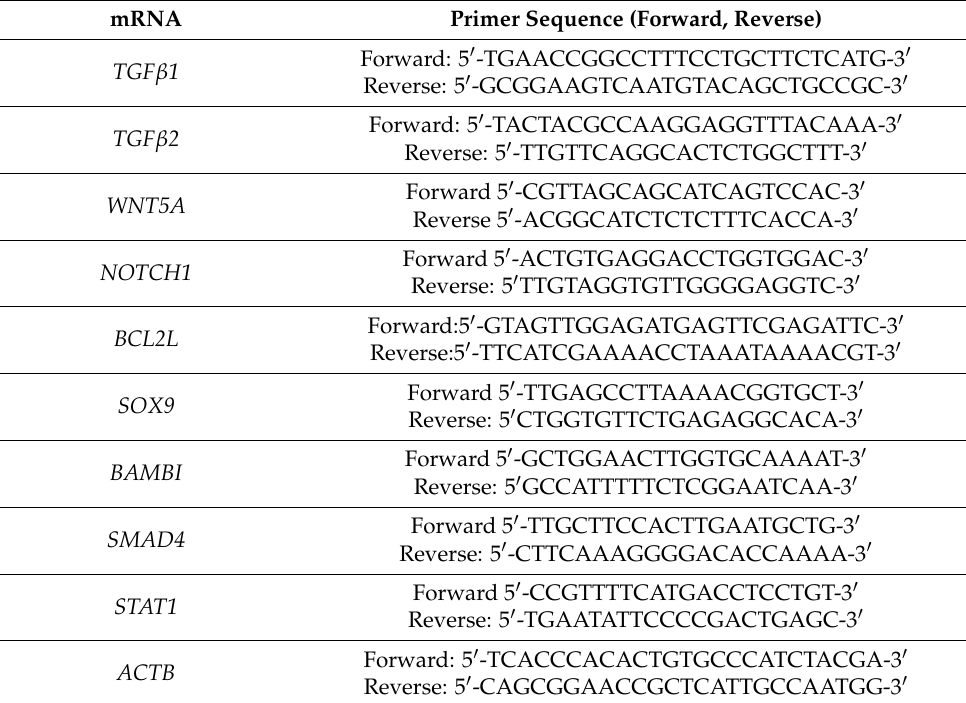
Table 2. The nucleotide sequence of primers used to amplify genes differentiating the studies samples from the control via the Reverse-Transcription Quantitative Polymerase Chain Reaction (RTqPCR)